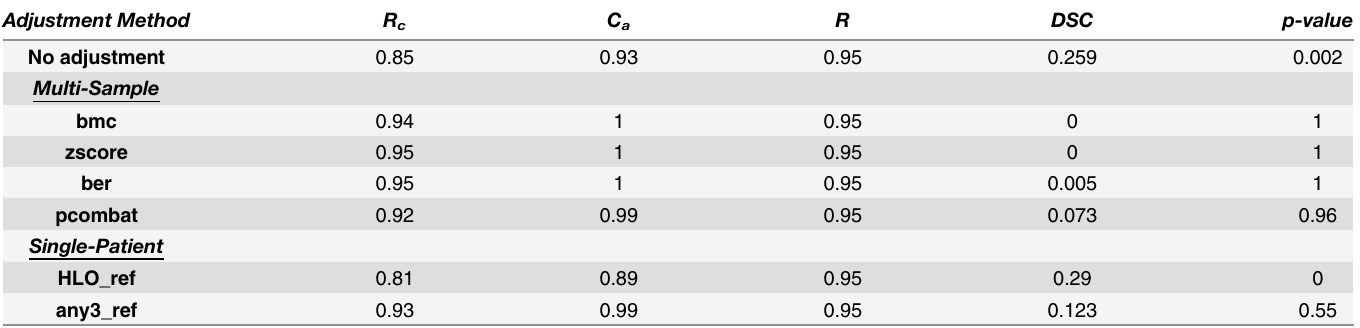
Table 3. Concordance between duplicates of HL clinical samples obtained from two CodeSets, after adjusting using different methods. Adjustment Method